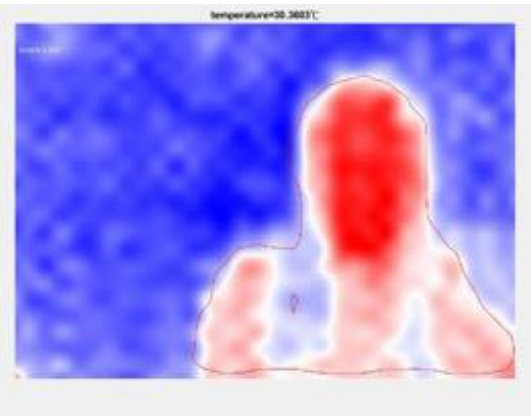
Figure 30. Display of people and temperature.